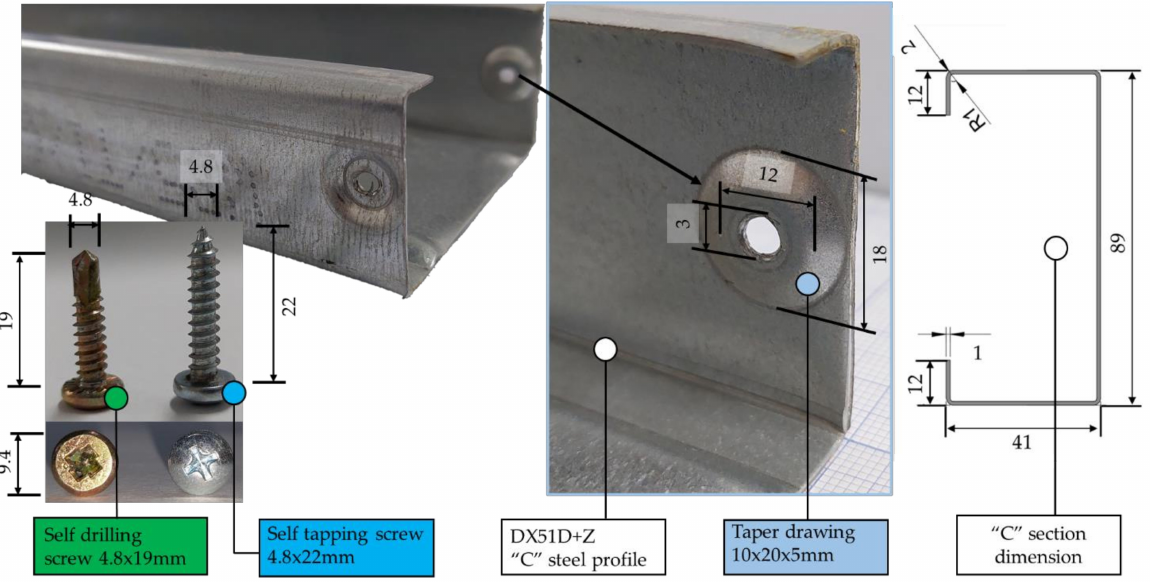
Figure 6. Types of screws and tapper drawing used for the